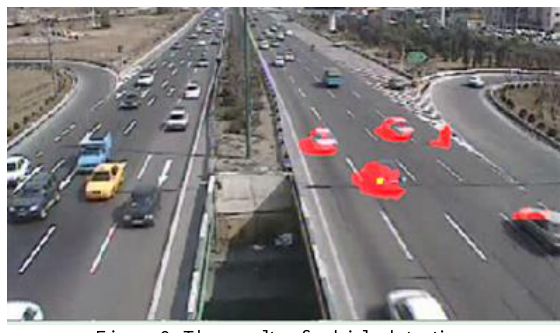
Figure 9: The results of vehicle detection.